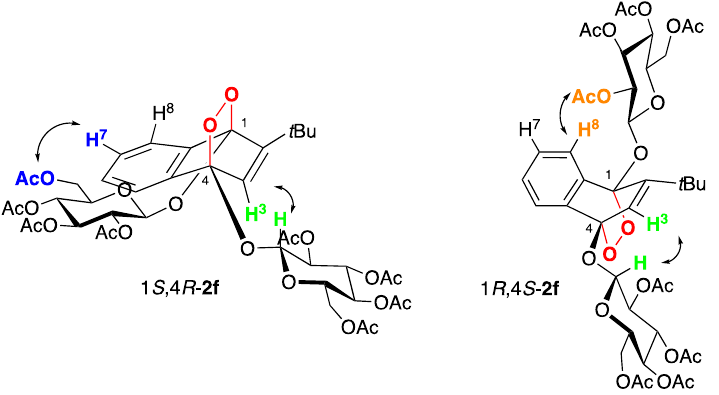
Figure 2. Characteristic NOE interactions in EPOs 1 S ,4 R - 2f and 1 R ,4 S - 2f .